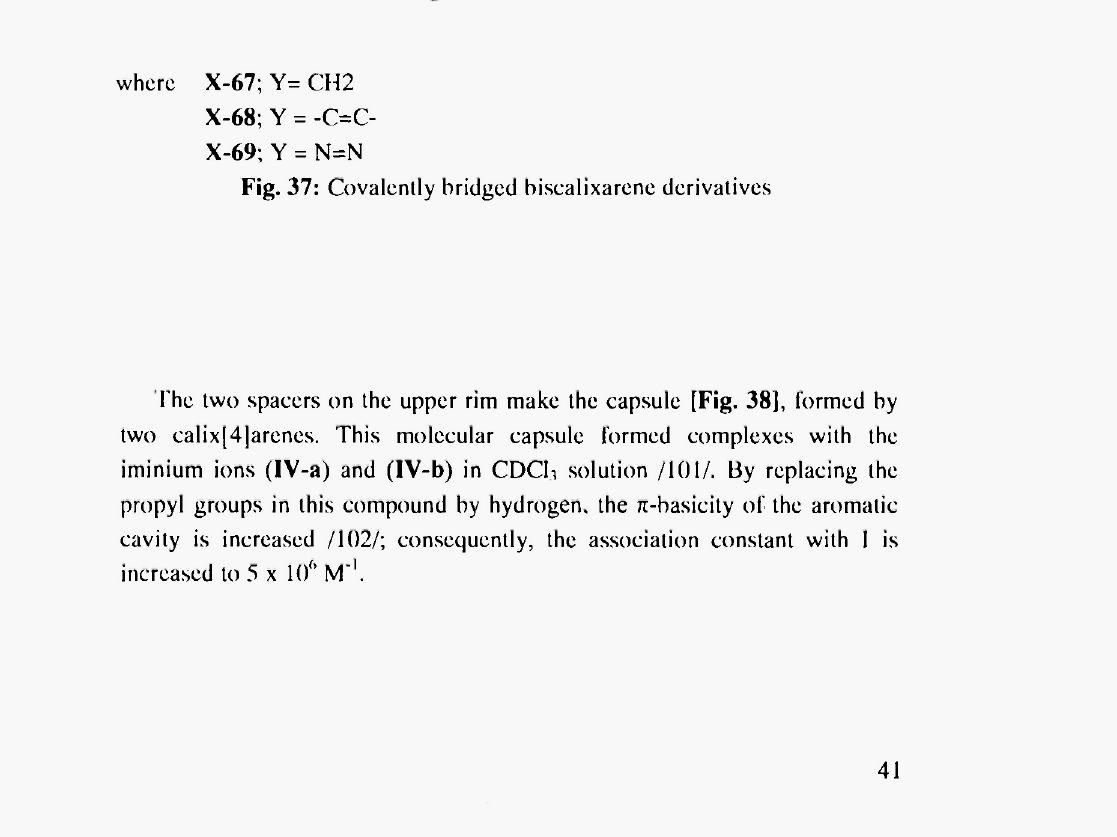
Fig. 37: Covalently bridged hiscalixarene derivatives